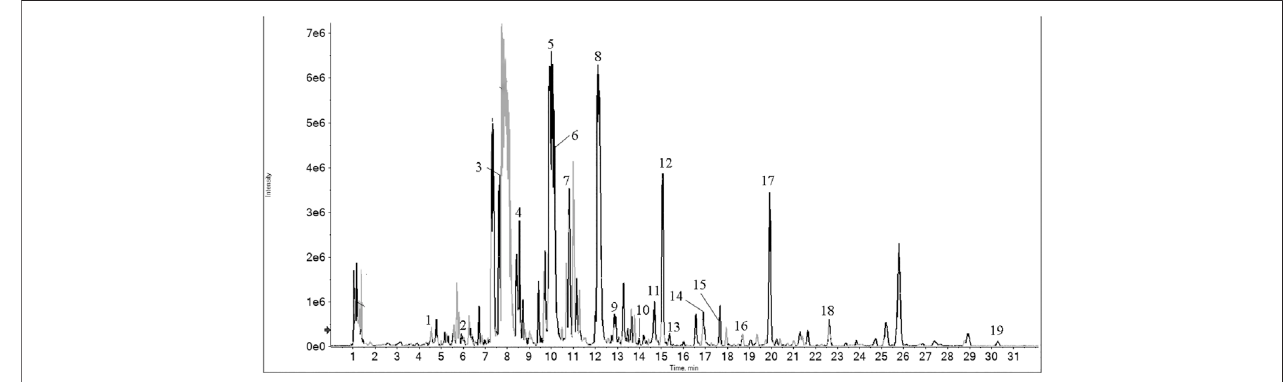
FIGURE 1 | HPLC-ESI/MSn total ion chromatograms of LTD.